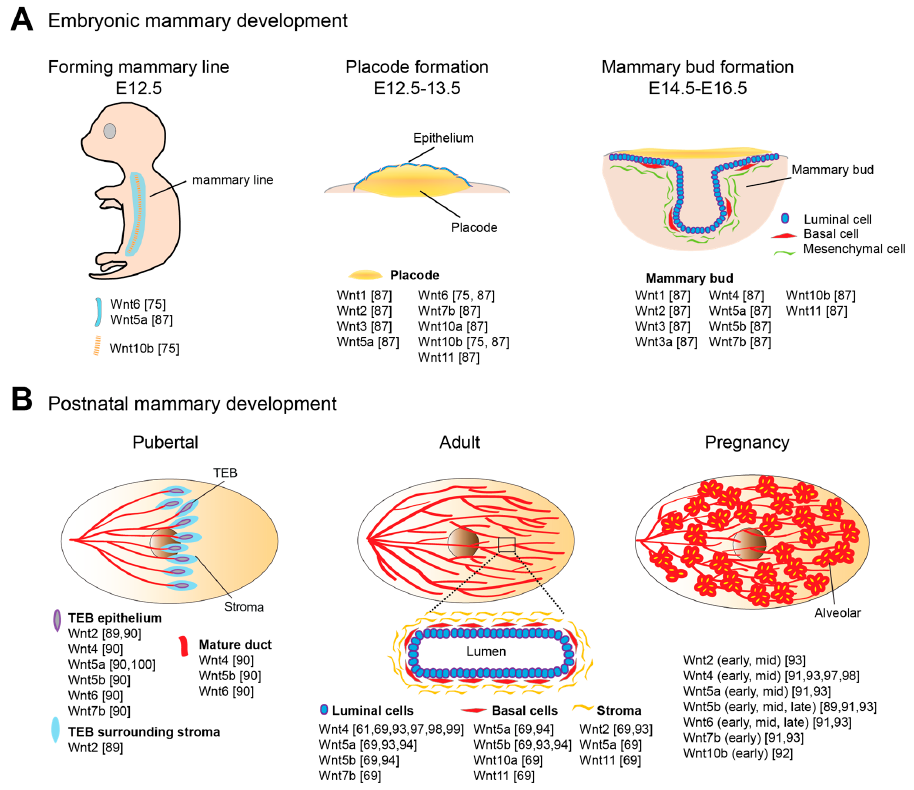
Figure 1. The expression of Wnts at various stages of mammary development. Expression